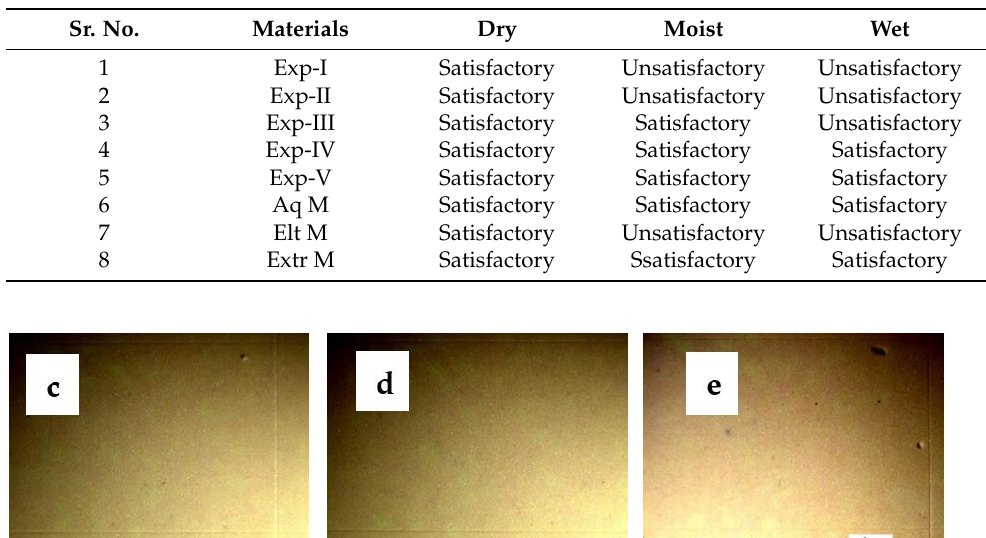
Table 4. Compatibility with gypsum products for commercial and Exp VPS (medium bodied) impression materials under dry, moist and wet conditions.